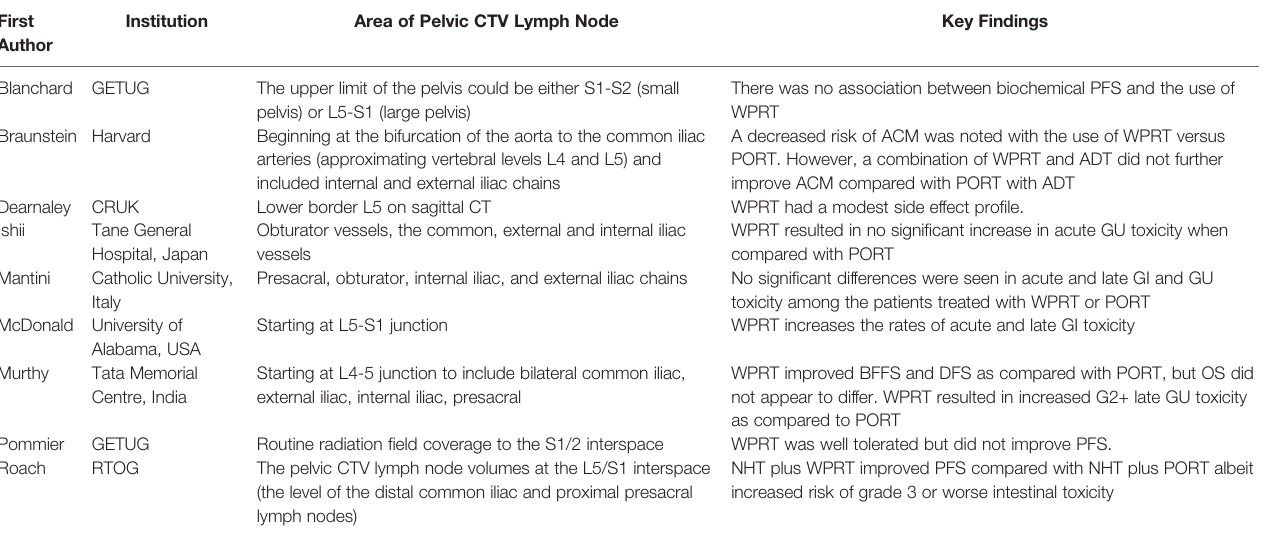
TABLE 4 | Pelvic CTV lymph node volume and outcomes of Non-RP studies.